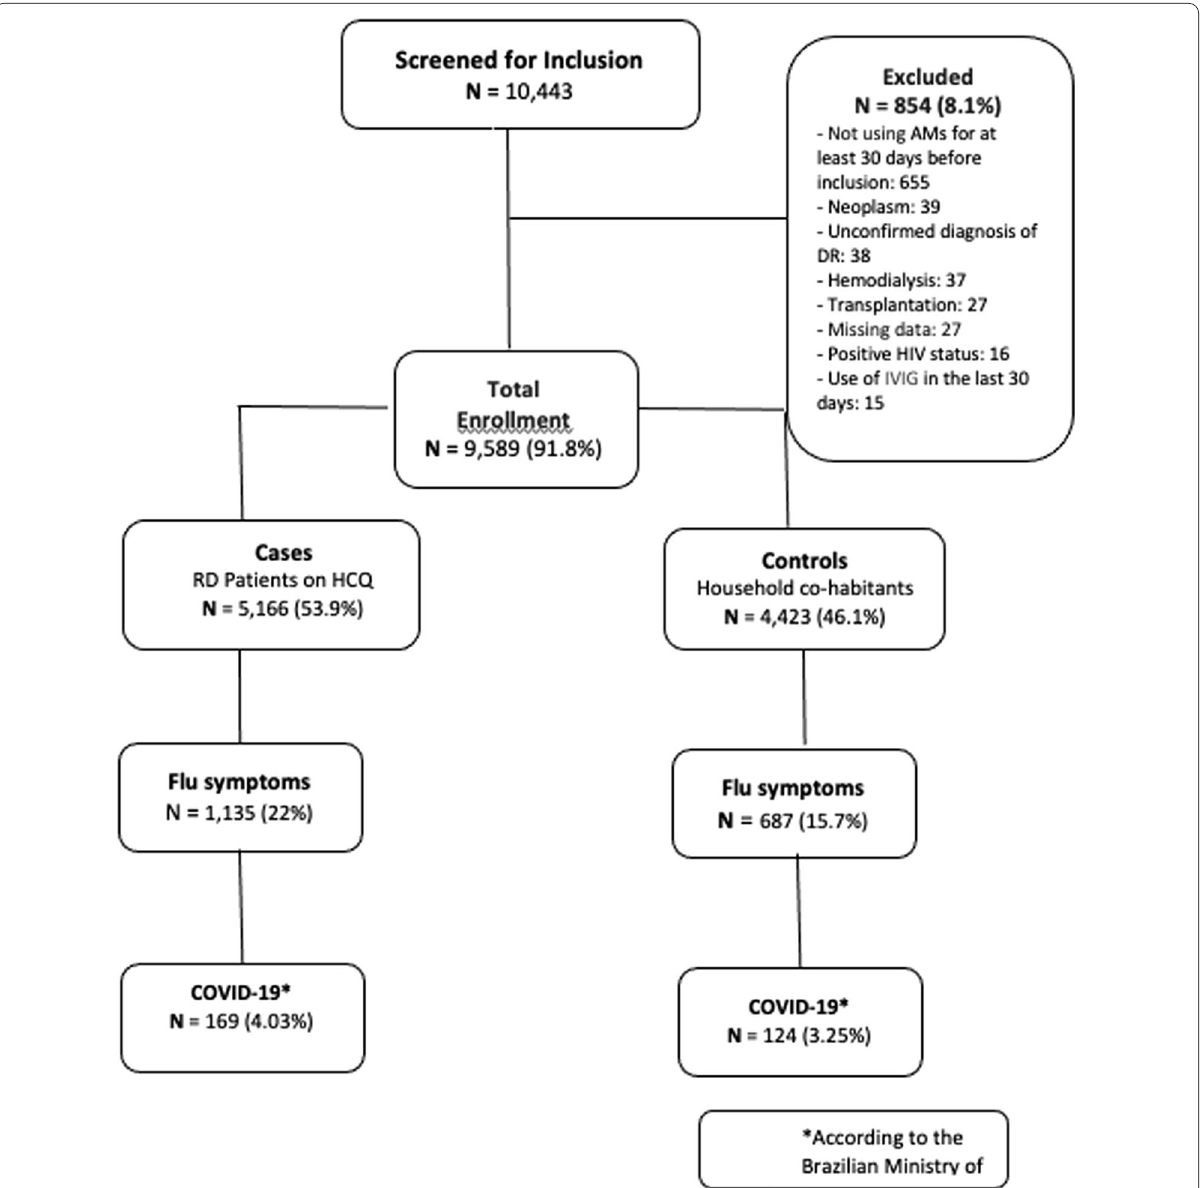
Fig. 2 Flowchart of participants enrolled in this study, considering influenza‑like illness symptoms and a diagnosis of COVID‑19, according to the Brazilian Ministry of Health